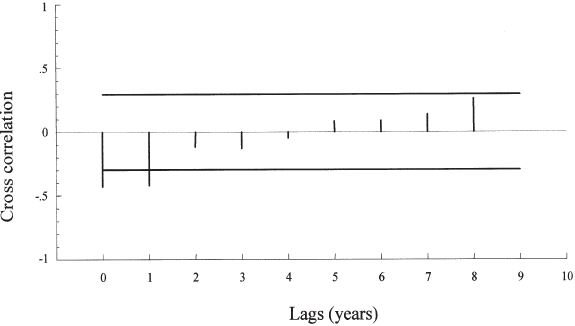
F IG . 9. – Estimated cross correlations between catches and mean northern winds at different time lags. The two horizontal bands represent the limits of significance at 5%